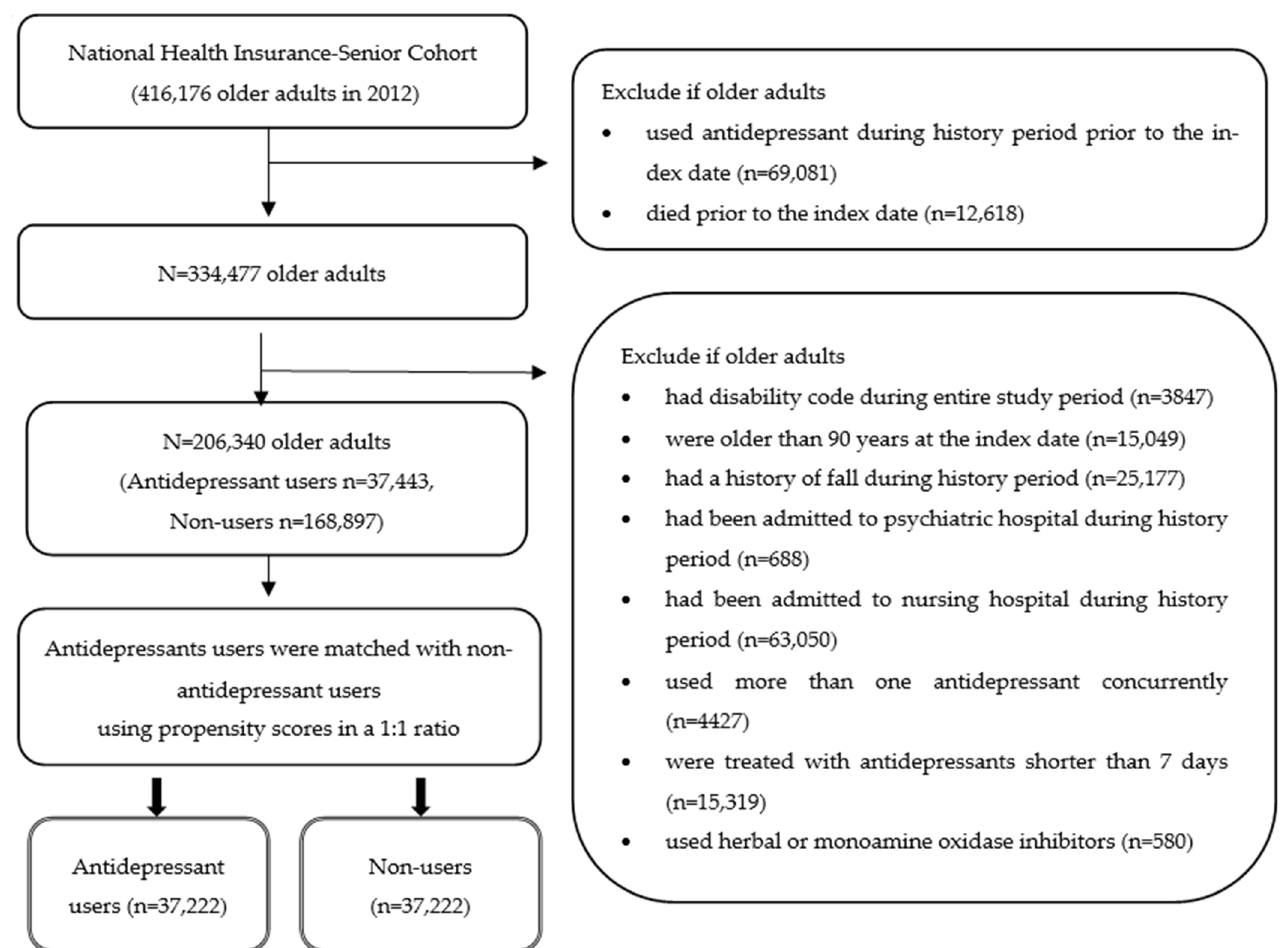
Figure 2. The process of study patient selection.